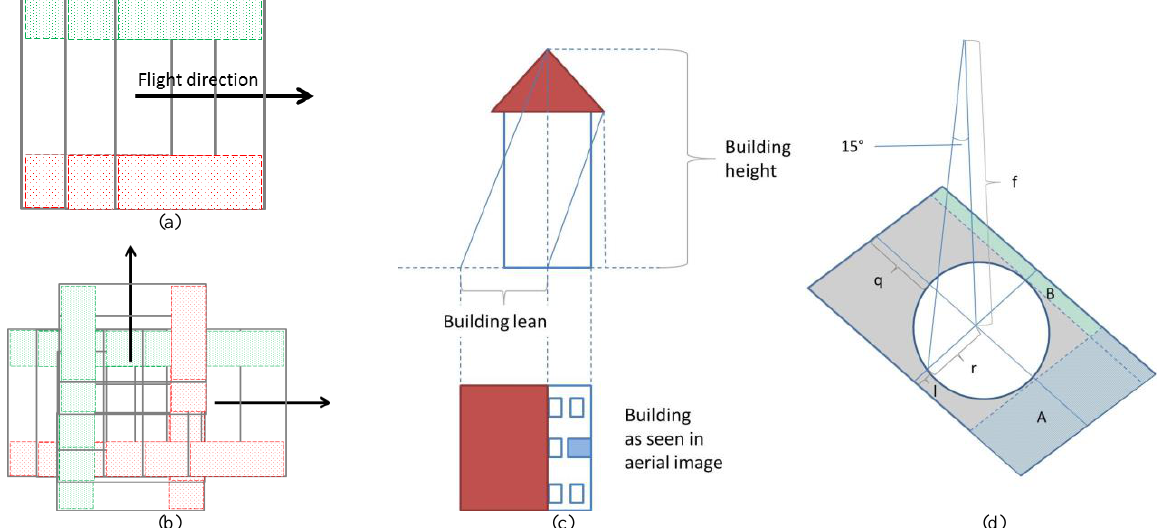
Figure 1. a) Image acquisition for the generation of semi-oblique images (red and green parts). b) Combined plans for nadir and 4 oblique views acquisition. c) Representation of building leaning effect. d) The part of the image (A) used for the semi-oblique views, as a function of the focal length (f) and desired minimal leaning angle.